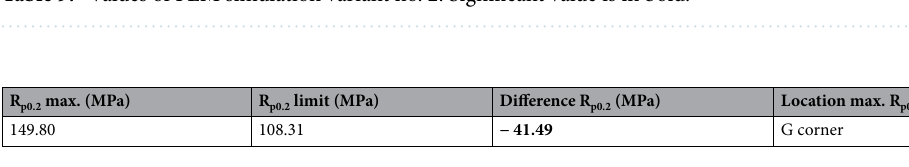
Table 10. Values from FEM simulation variant no. 3. Significant value is in bold.